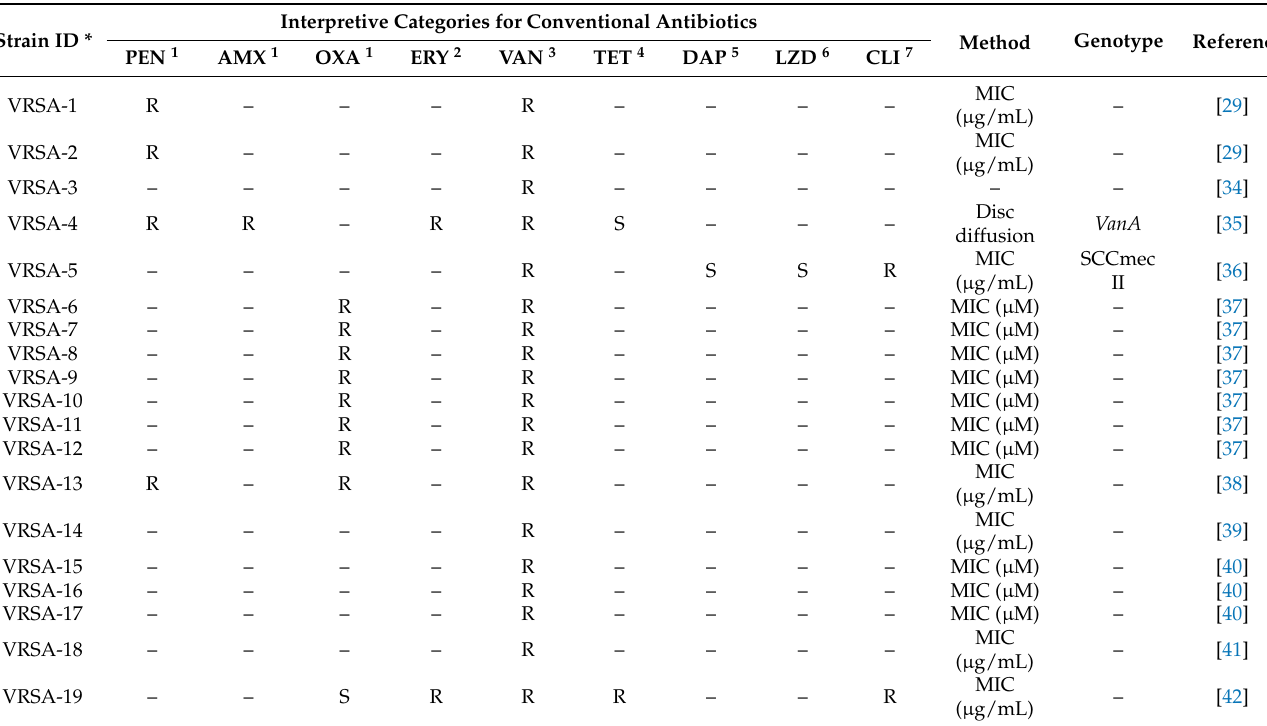
Table 1. Resistance profile of VRSA and VISA strains that showed susceptibility to AMPs. Interpretive Categories for Conventional Strain ID *